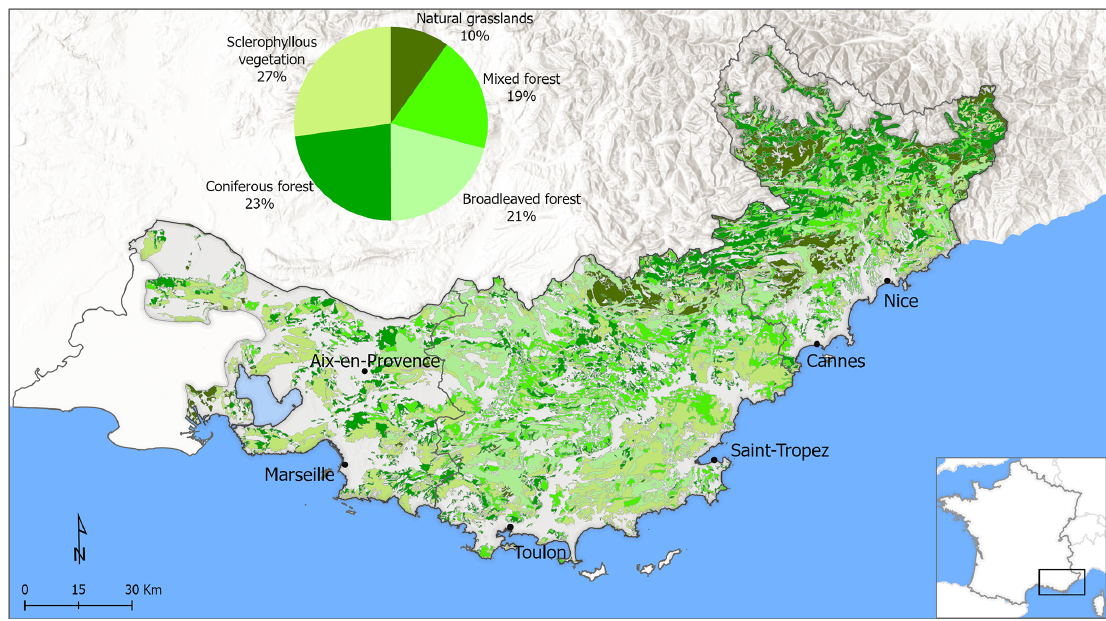
Figure 3. Distribution of vegetation types based on CLC 2018.